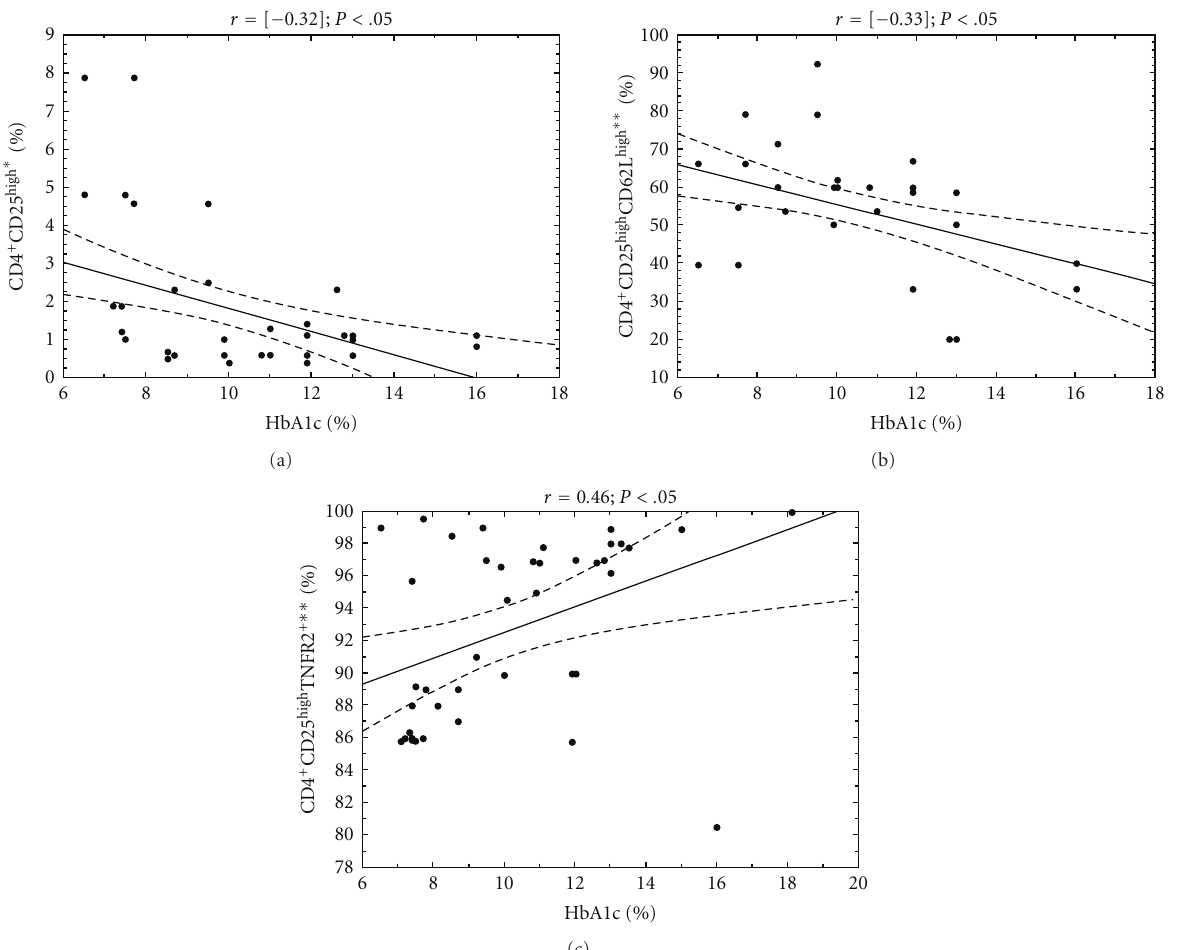
Figure 3: Relationship between CD4 + CD25 high regulatory T-cells, their subpopulations frequencies, and HbA1c level in analyzed DM1 subjects. The level of HbA1c was measured in the blood of DM1 children and correlated with the percentage of peripheral blood regulatory T-cell subpopulations. The Spearman test was used to calculate the strength of correlation. (a) The correlation between CD4 + CD25 high frequency and HbA1c level in DM1 subjects ( r = [ − 0 . 32]); (b) the correlation between CD4 + CD25 high CD62L high frequency and HbA1c level in DM1 subjects ( r = [ − 0 . 33]); (c) the correlation between CD4 + CD25 high TNFR2 + frequency and HbA1c level in DM1 subjects ( r = 0 . 46). ∗ The percentage of cells among peripheral blood lymphocytes, ∗∗ the percentage of cells among CD4 + CD25 high lymphocytes.